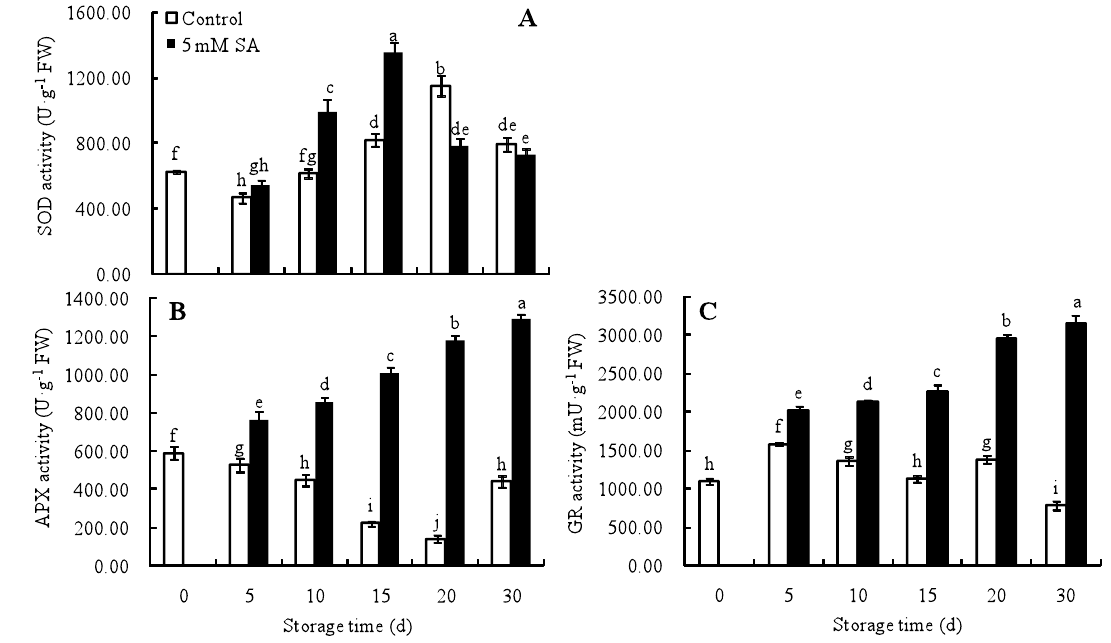
Fig. 3: Changes of activities of SOD (A), APX (B) and GR(C) of peel in ‘Huangguan’ pear by SA treatment during cold storage. Values are mean ± SE of three replicates. Different letters represent significant differences at P = 0.05.